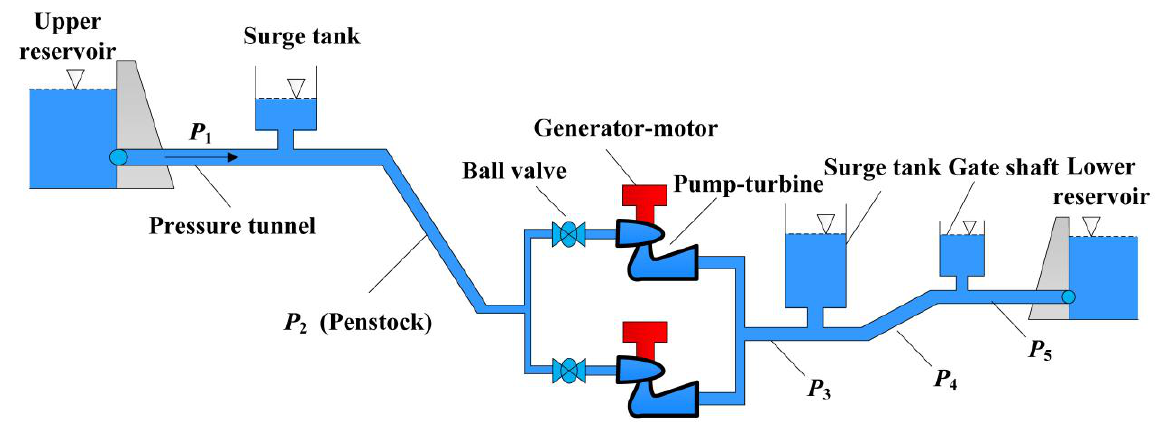
Figure 7. Layout of the pipeline of a pumped storage power station.